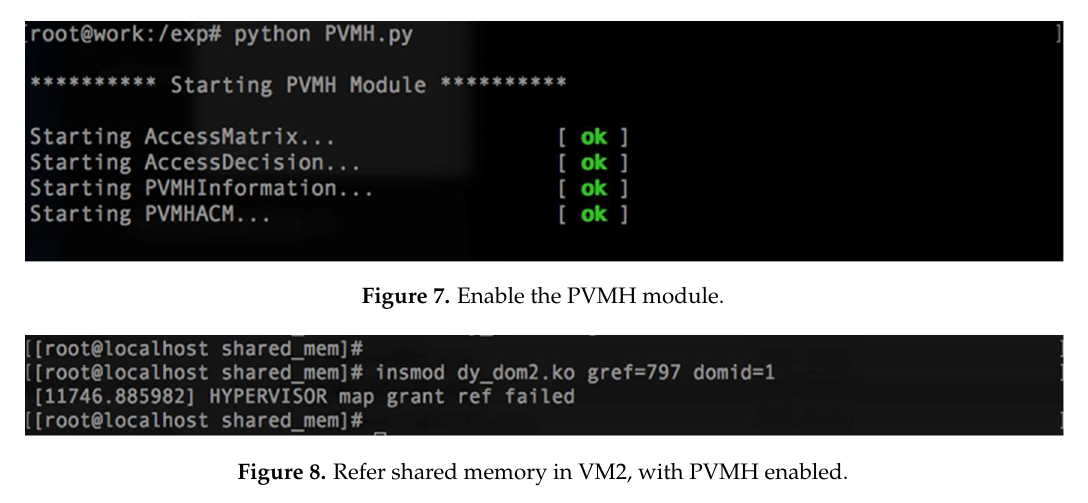
Figure 6. Refer shared memory in VM2, without PVMH module.